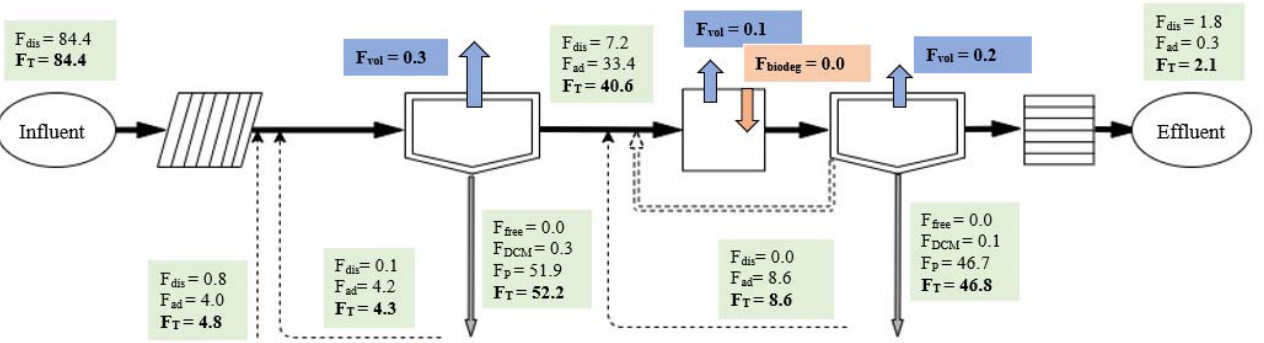
Figure 4. Fate of benzo(a)pyrene in the water line. Results are presented in g/day. F dis is the resulting load in the dissolved phase, F ad is sorbed to particles in the water line, F free is freely dissolved, F DCM is sorbed to the dissolved and colloidal matter (DCM), and F p is sorbed to particles going to the sludge line.